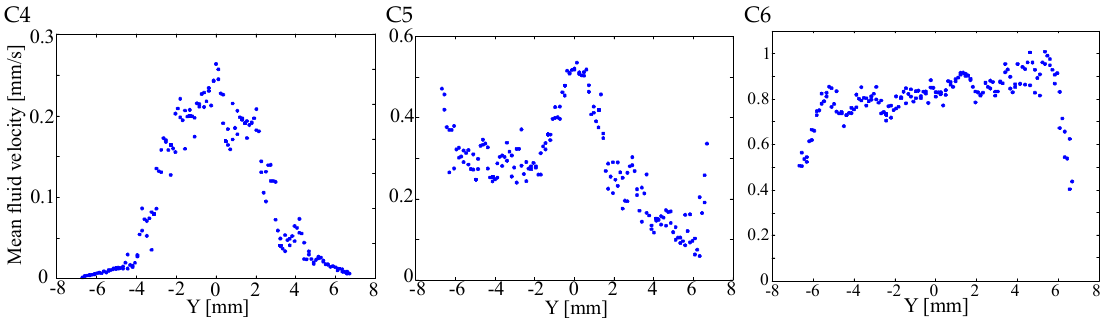
Figure 12. Profile of the mean flow velocity (mm/s) in the middle of the chamber measured using particle image velocimetry for the microfluidic interface configuration (left) C4, (center) C5, and (right) C6.